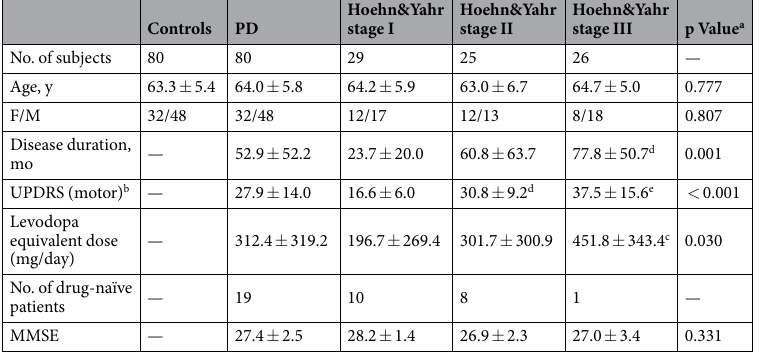
Table1. Demographic and clinical profiles of PD patients and control groups. Abbreviations: PD = Parkinson disease; UPDRS = Unified Parkinson’s Disease Rating Scale; MMSE = Mini Mental State Examination. The data are presented as mean ± SD. a Analysis of variance with the exception of chi-square for gender. b Off-state motor ratings according to the UPDRS. c p < 0.05 vs. Hoehn & Yahr stage I group. d p < 0.01 vs. Hoehn & Yahr stage I group. e p < 0.001 vs. Hoehn & Yahr stage I group.